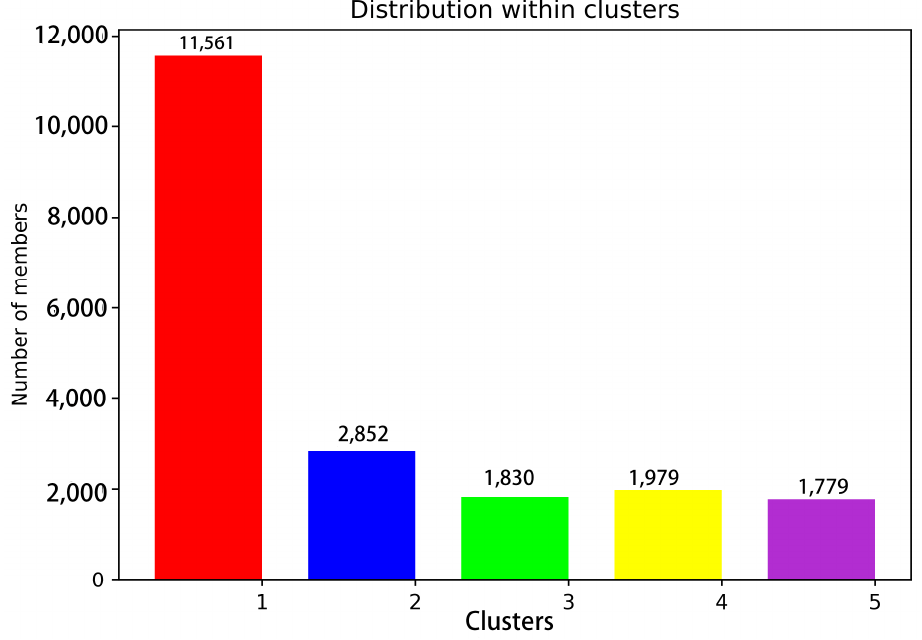
Figure 2. The main conformation extracted from pS273R in 200 ns simulation duration. ( A ) Crystal structure of five major conformation clusters in pS273R. Note: Black box means the loop region of Thr159 ‐ Lys167 of pS273R. ( B ) Surface structure of pS273R Crystals. ( C ) Surface structure of Cluster 1. ( D ) Surface structure of Cluster 2. Note: Oxygen atoms of His168, Cys232, and Asn187 residues are red, nitrogen atoms are blue, and sulfur atoms are yellow.